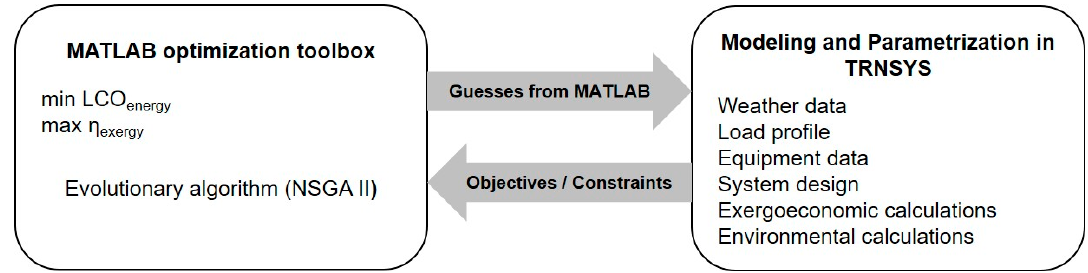
Figure 6. Computational model.